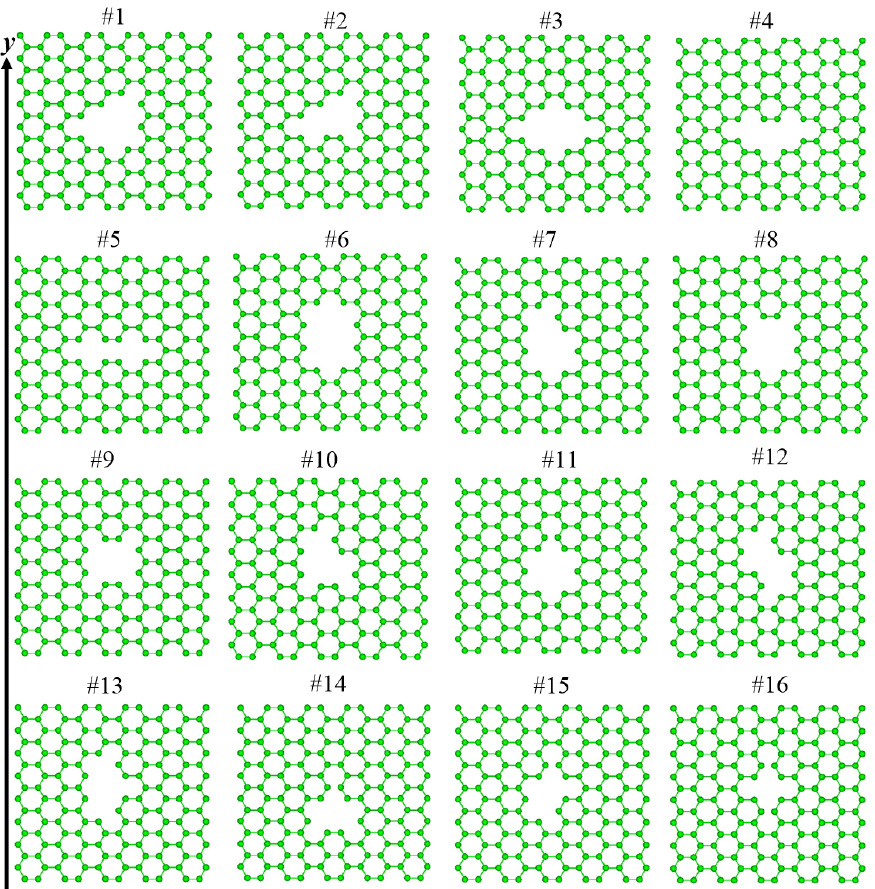
Figure 1. Sixteen initial structures of graphene having defects. Nanomaterials 2022 , 12 , x FOR PEER REVIEW